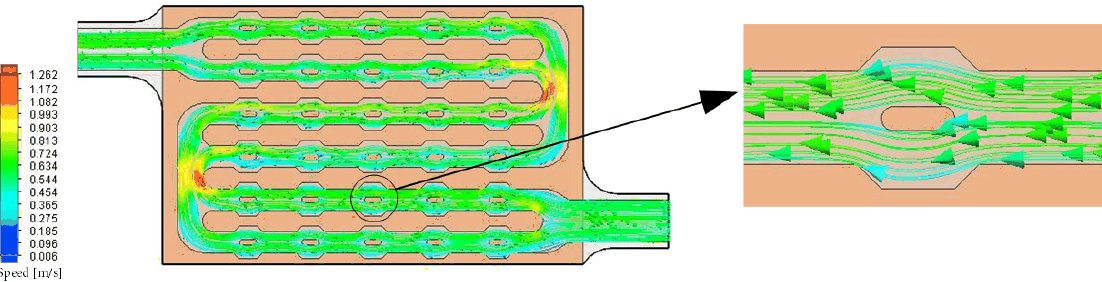
Figure 14. Fluid trace inside mini-channel in plan 5.